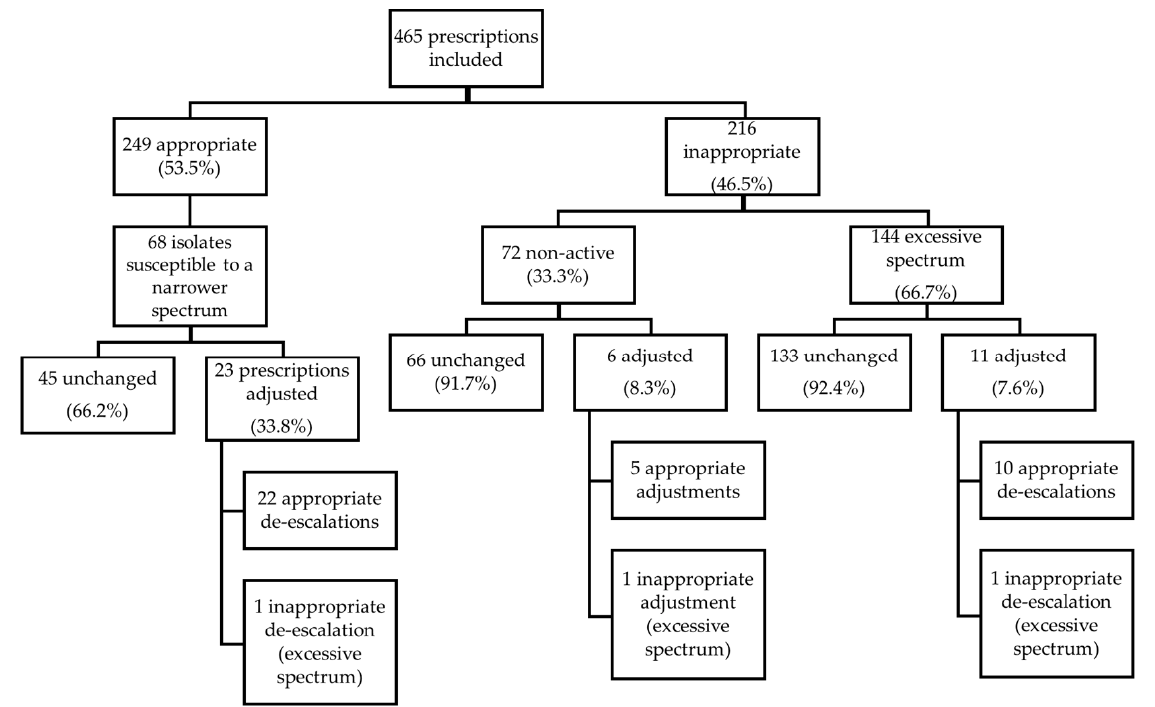
Figure 1. Appropriateness of initial prescriptions of ceftriaxone and de-escalation or further prescription changes.